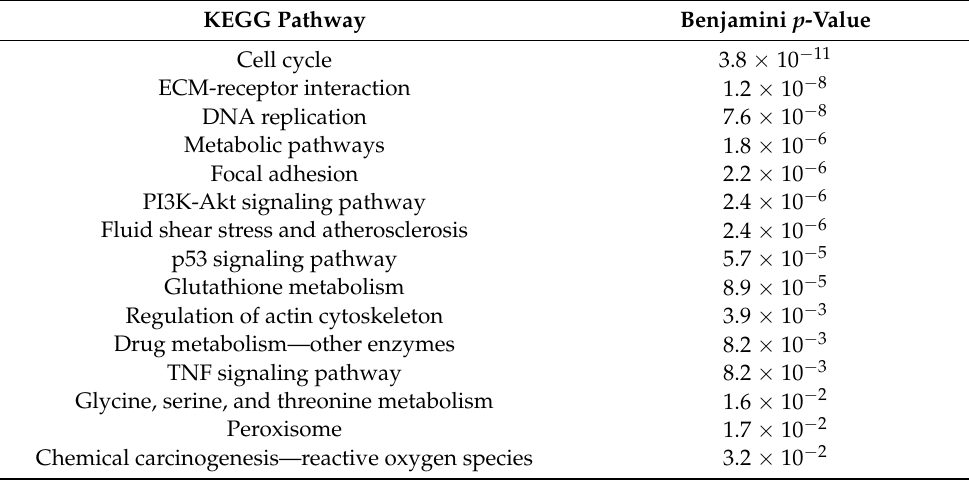
Table 2. KEGG (Kyoto Encyclopedia of Genes and Genomes) pathways enriched in overlapping differential expression